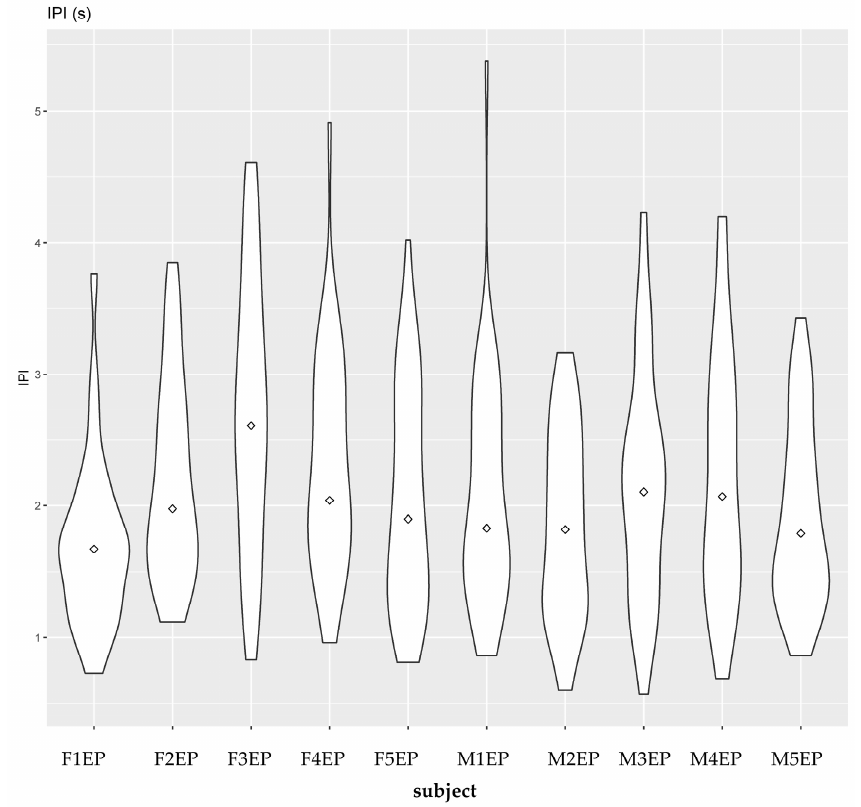
Figure 8. IPI (s) violin plots for the ten Portuguese subjects of the Current Set. The five left-hand plots are from female reciters and the five right-hand plots from male reciters.